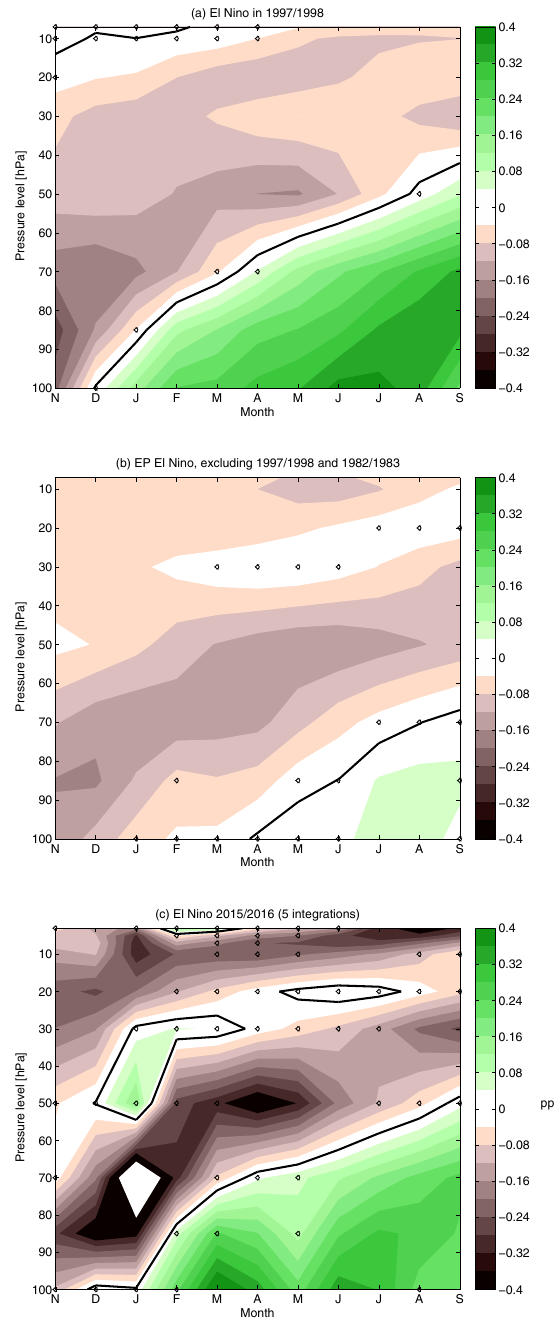
Figure 5. Water vapor anomalies (ppmv) for the 42 AGCM GEOSCCM integrations in (a) 1997/1998; (b) all EPEN events ex- cept 1997/1998 and 1982/1983; (c) 2015/2016 in the five integra- tions that have been extended to the near present. Anomalies that are not significant at the 95% level are marked by black symbols. The effect of the QBO at 50hPa and the linear trend have been linearly regressed out of all anomalies before EN composites are formed (see Sect.